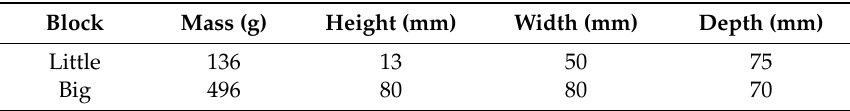
Table 1. Parameters (mass and dimensions) of the blocks used to improve the simulation of soft tissue artifact (STA).